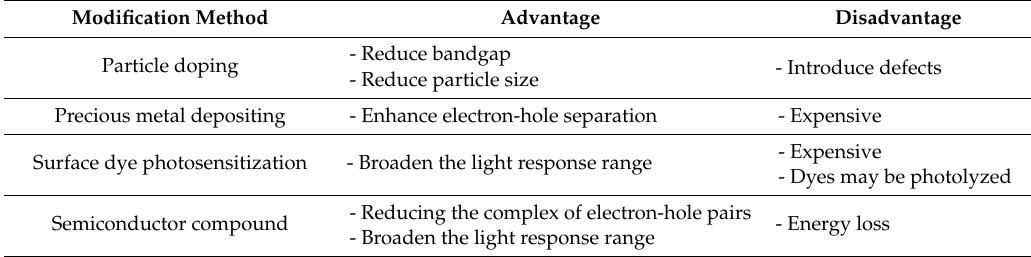
Table 3. Advantages and disadvantages of di ff erent modification methods for